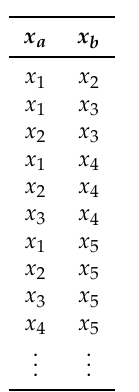
Table 3. Genetic Algorithm parent pair generation